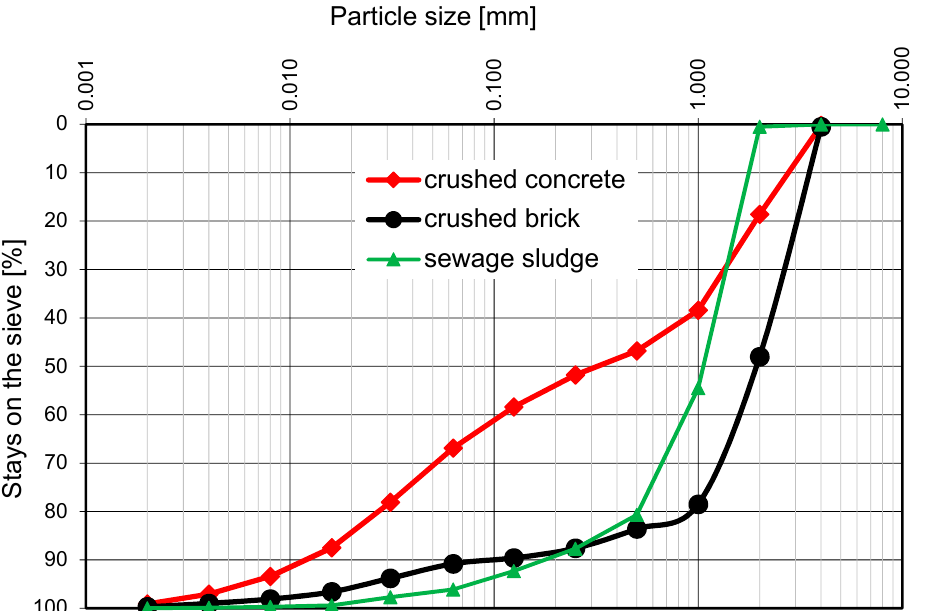
Figure 3. The grain size distribution curves of the recycled aggregates. Table 1. The compositions of concrete